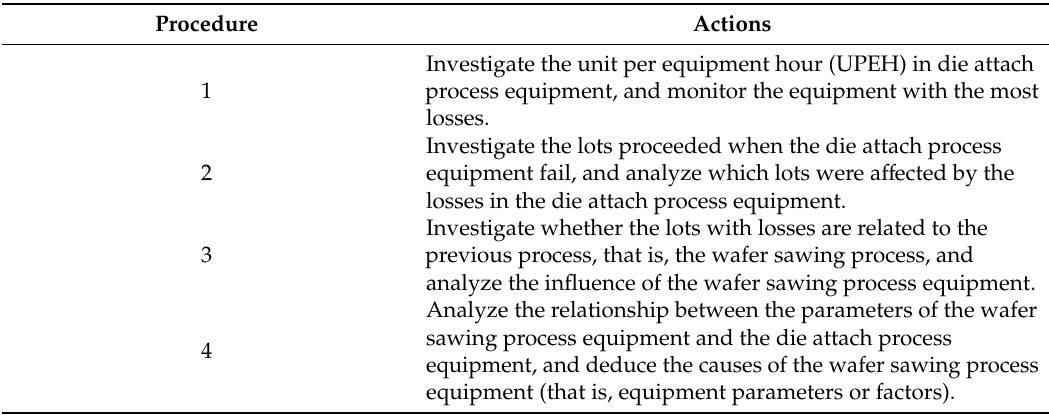
Table 5. Development procedure of quality loss